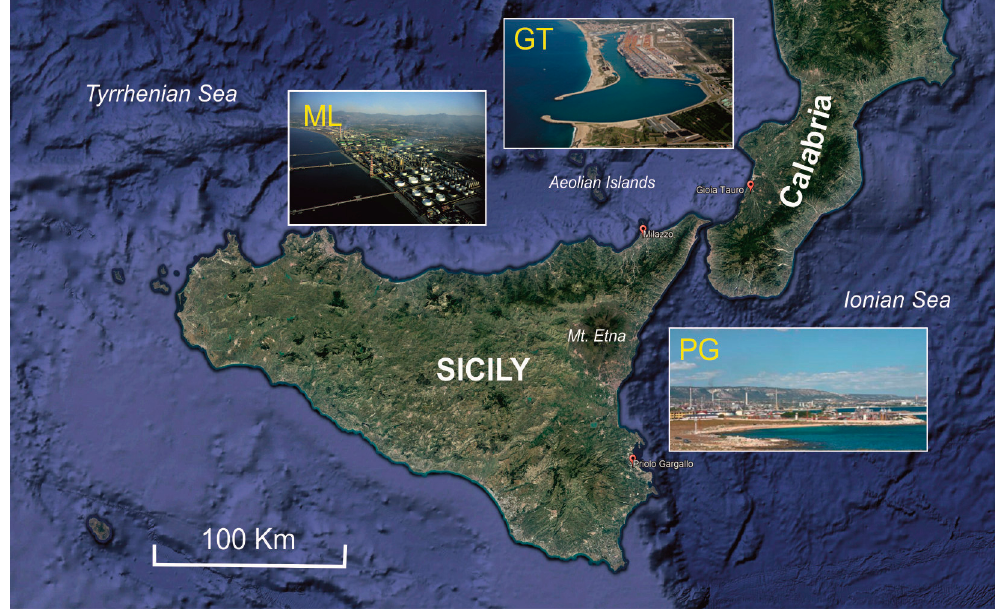
Figure 4. Critical infrastructure used as test sites for the HYPSTHER project. GT, port of Gioia Tauro; ML, Milazzo refinery; PG, petrochemical complex of Priolo Gargallo.